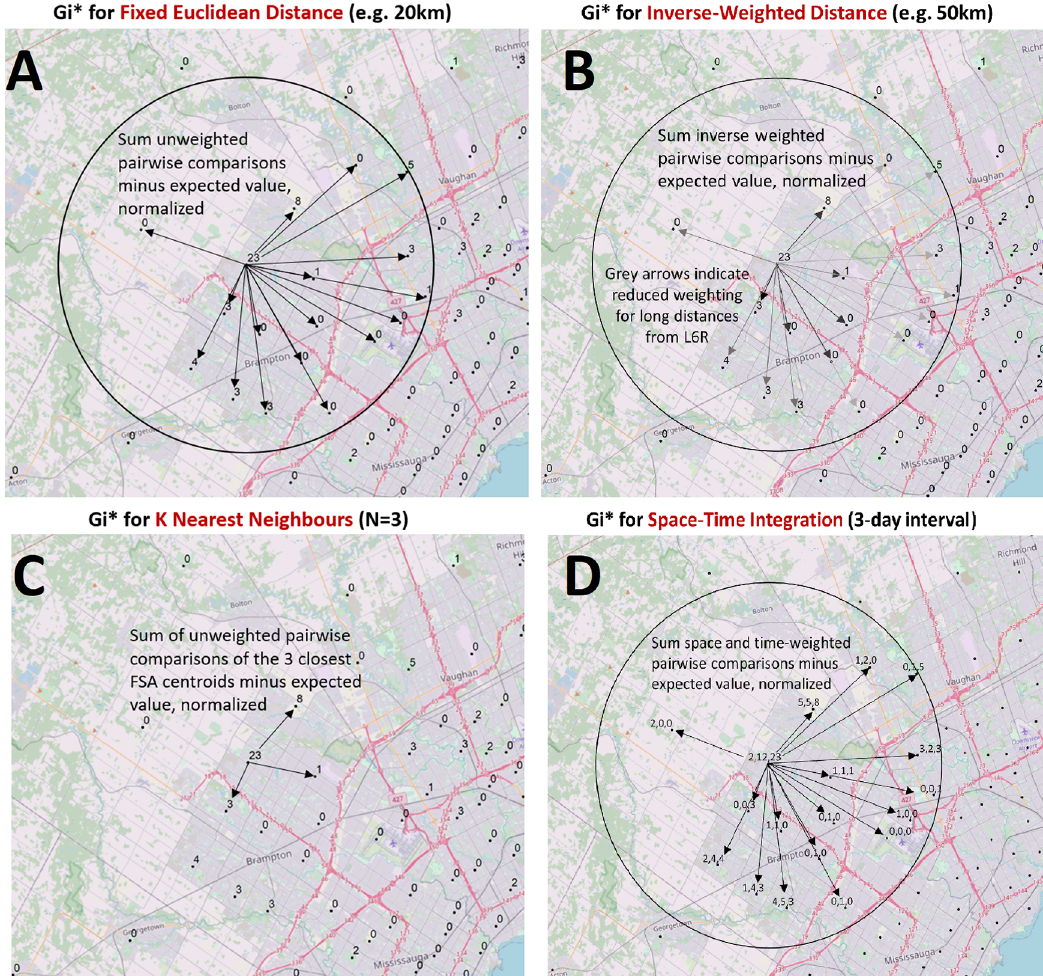
Figure 1. Modeling spatial relationships by area-to-area geostatistical analyses. Case counts aggregated at the centroids of FSAs or PCs over daily- or multi-day windows are compared to cases in neighboring FSAs or PCs and evaluated with geostatistical tests. These spatial relationships are defined by modeling spatial interactions between the FSA or PC being evaluated and the neighbors being tested. The panels describing these interactions indicate: (A) The fixed distance band weighs all neighbors within a specified distance equally (weights [ w i,j ] are equal for features within circle; for all other features, w i,j = 0), (B) The inverse distance band is based on distance decay where neighbors further from the target feature is weighted less relative to closer neighbors ( w i,j = d i,j- β where d i,j is the Euclidean distance between two points and β is the inverse distance power variable; β = 1 in this study), (C) K-Nearest Neighbors constructs a spatial relationship which assesses a feature with a specified number of its most proximate neighbors based on centroid distances (here, K = 3, where each K neighbor is weighted equally), (D) Space-Time integration defines feature relationships in terms of both a space (fixed distance) and a time window. Features that areproximate toone anotherin space and timeare analyzedtogether (equal weights), as relationships areassessed relative to the location and time stamp of the target feature. Area-to-area geostatistical tests used include Gi* analysis, Cluster and Outlier analysis, and Spatial